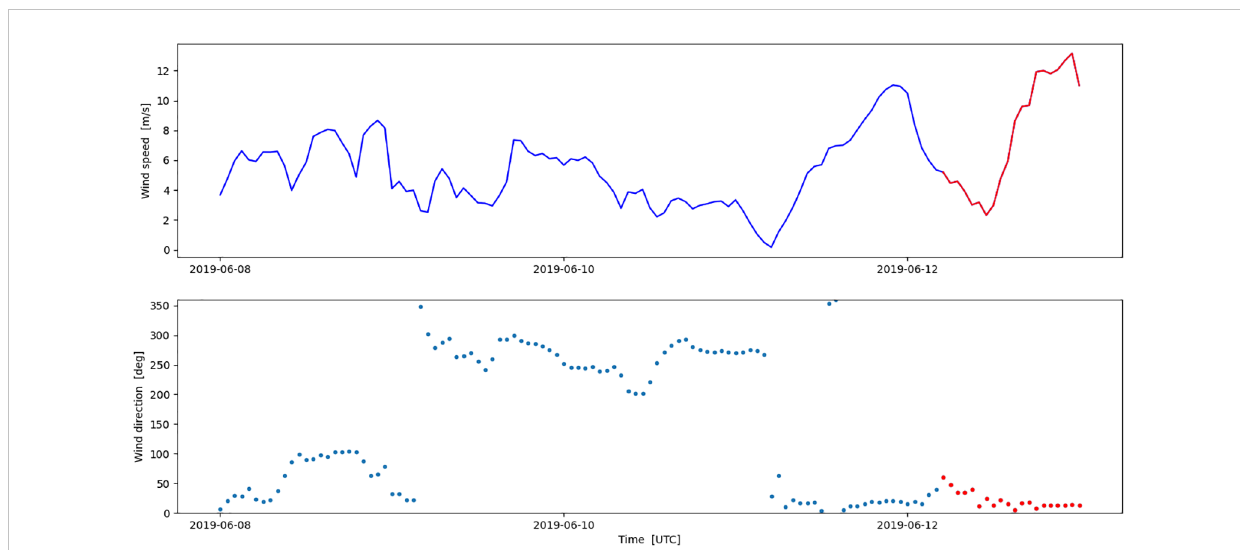
FIGURE 2 Wind speed and direction the last 7 days before the campaign period, provided by the regional weather prediction model Arome MEPS (Müller et al., 2017). The experiment period 12 June 04:00 UTC to ¨ 13 June 00:00 UTC is marked with red